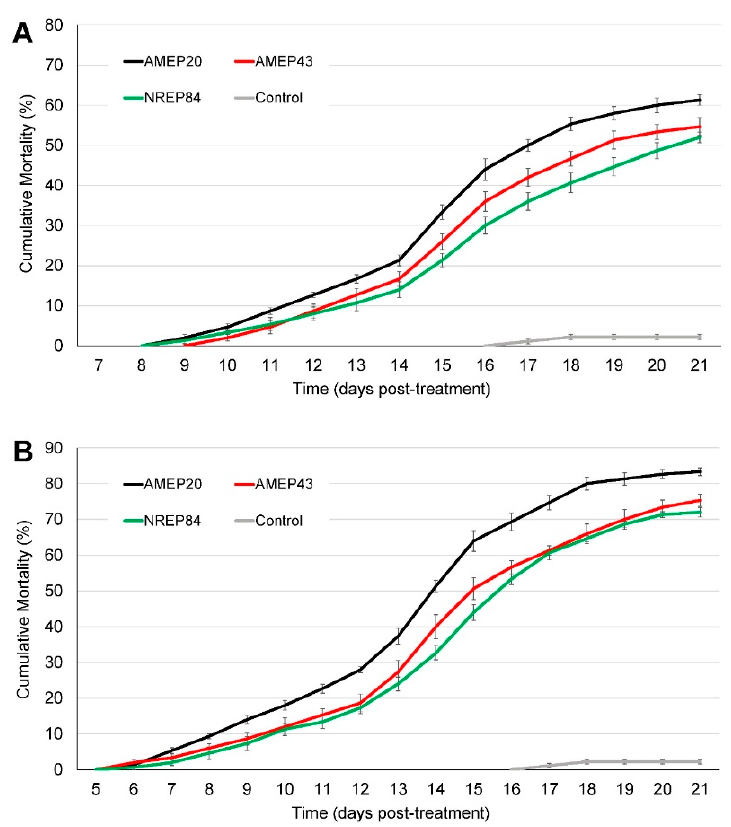
Figure 3. Mean cumulative mortality data (%) with standard errors of Hylobius abietis adults after their inoculation with conidia suspensions of Beauveria strains at concentrations of 1 × 10 8 conidia mL − 1 ( A ) and 1 × 10 9 conidia ml − 1 ( B ).